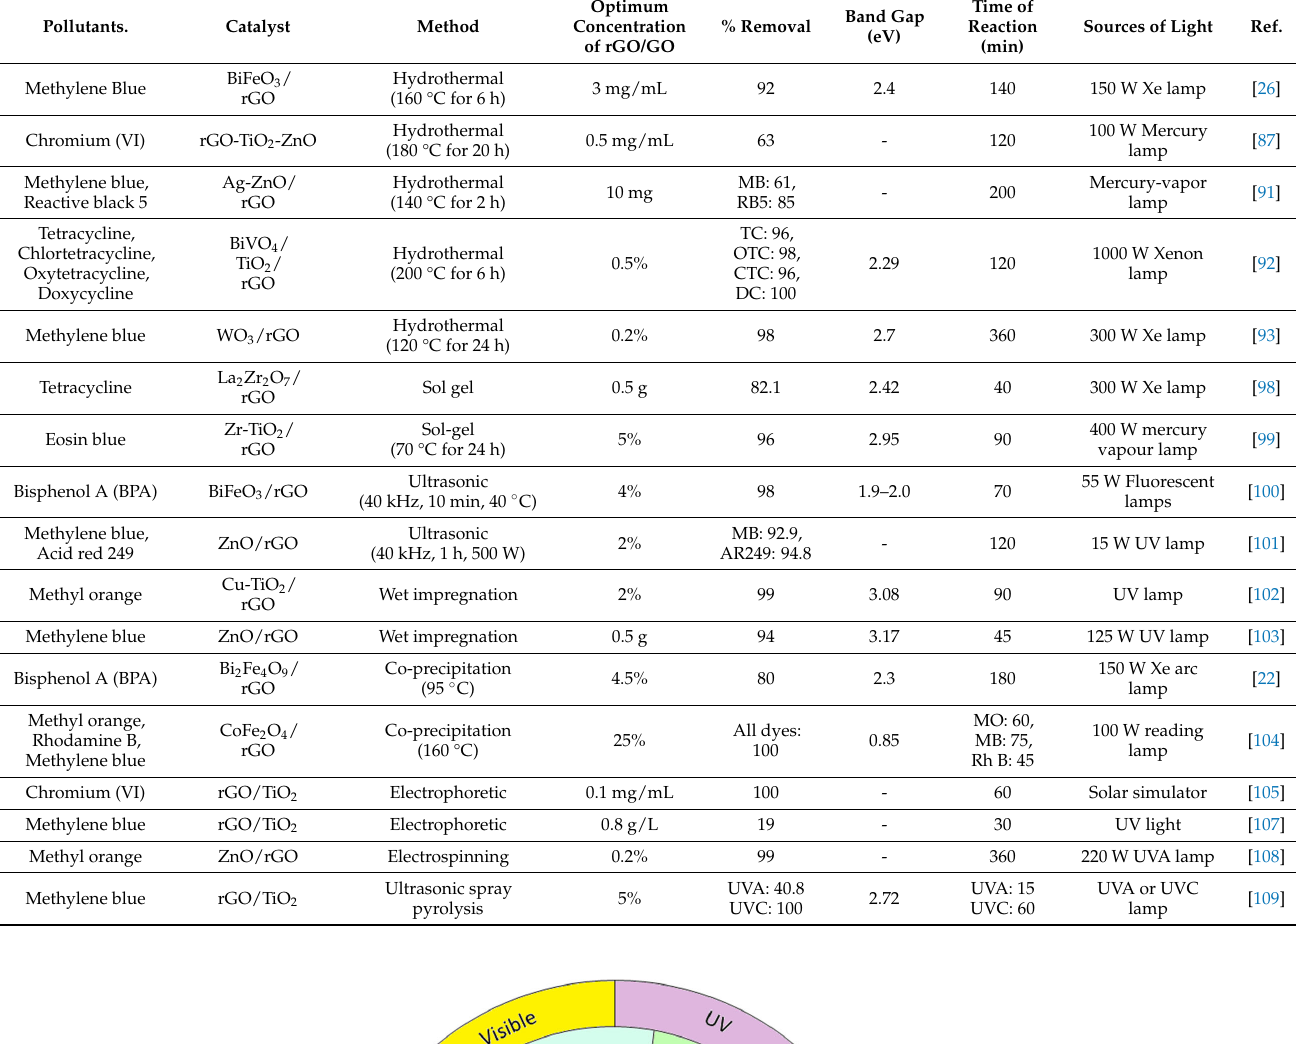
Table 2. Hybridization of various metal oxides with reduced graphene oxide (rGO) using different methods. Pollutants.